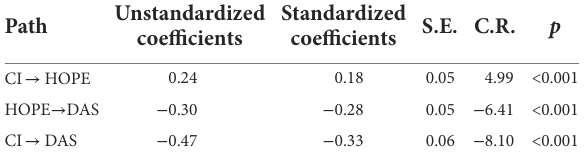
TABLE 3 Consistency of interest path analysis.